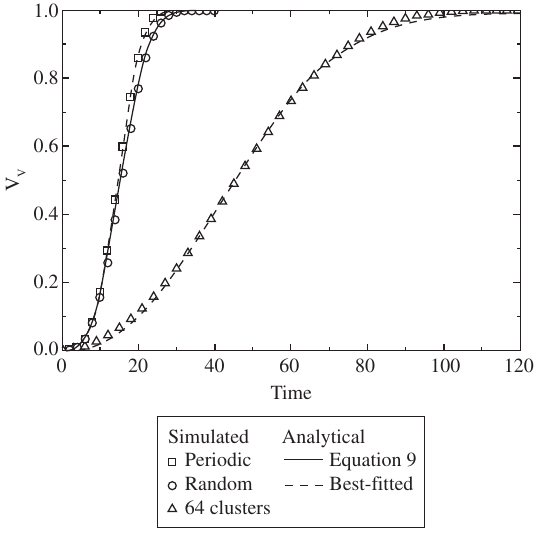
Figure 6. Volume fraction against time, simulated by CA. Simulation data are force fitted by JMAK kinetics, Equation 9.